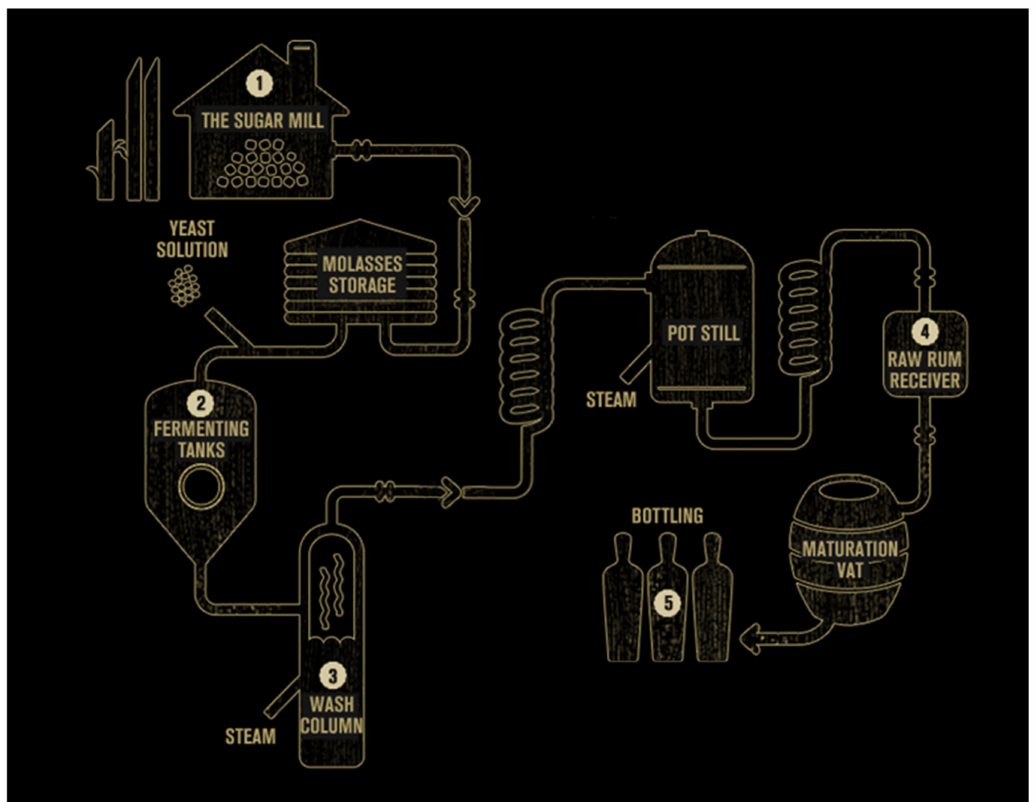
Figure 1. A general overview of the rum production process. Modified from Bundaberg Rum (https://www.bundabergrum. com.au/ (accessed on 8 February 2021)); used with